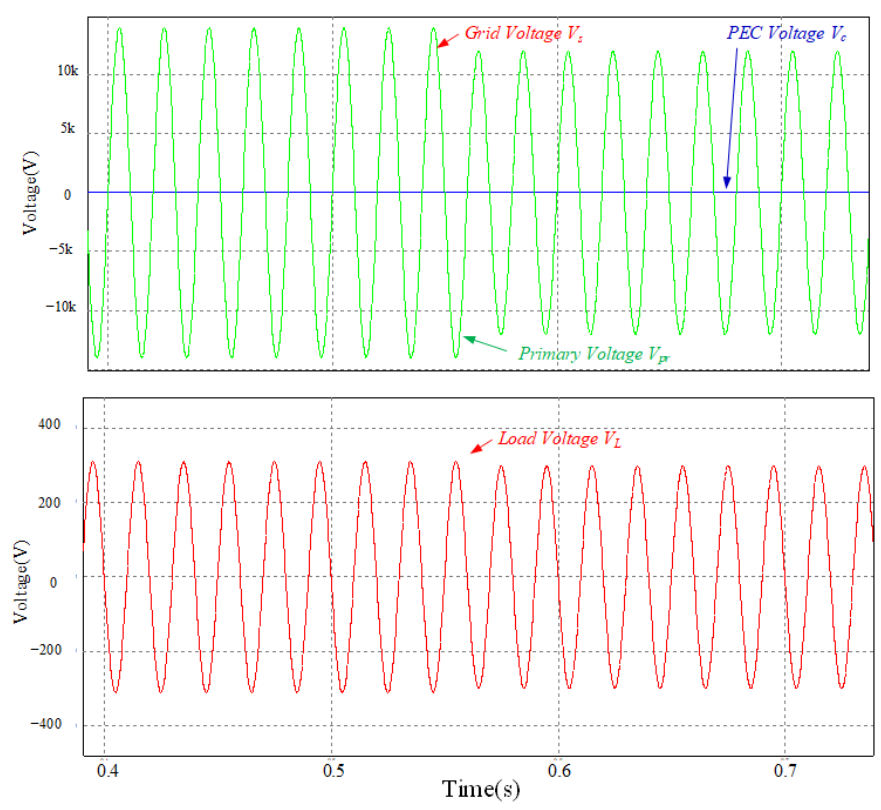
Figure 13. Voltage waveforms during voltage regulation with OLTC